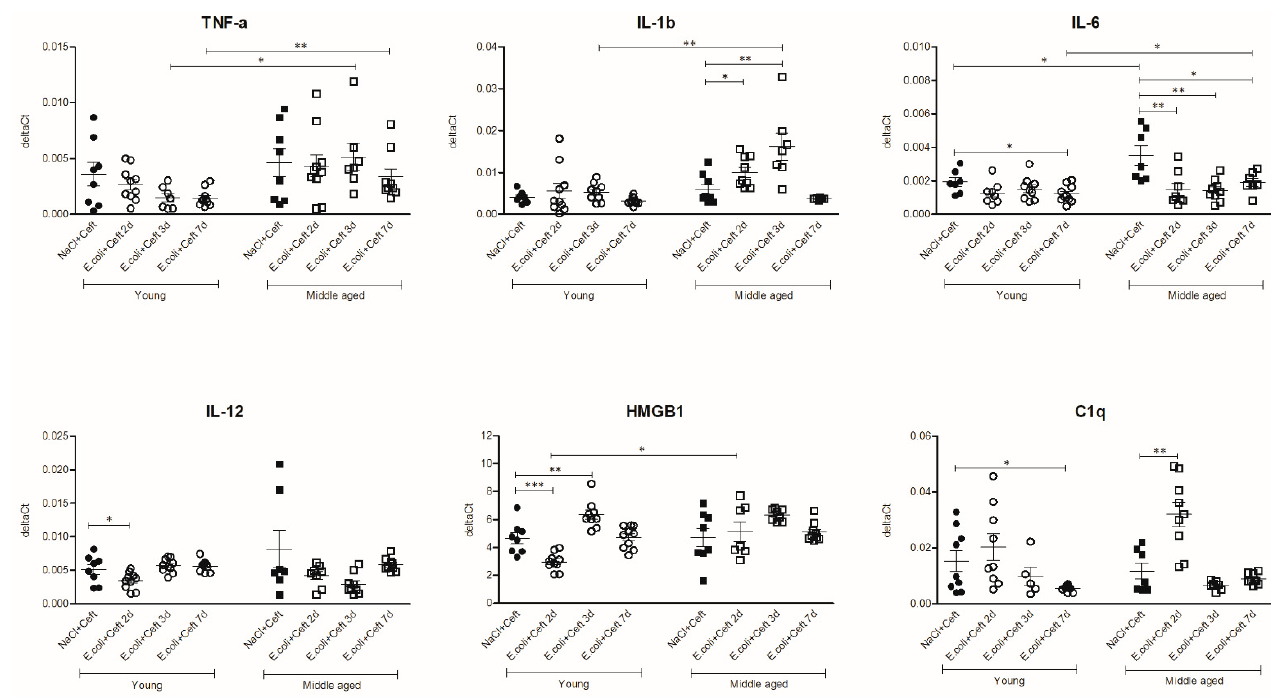
Figure 5. mRNA expression of brain homogenate of general pro-inflammatory mediators TNF- α , IL-1 β , IL-6, IL-12, HMGB1 and C1q, illustrated in deltaCts. Group size varies from n = 8 to 10. Parametric or non-parametric two-way ANOVA (factors: age and time point) werer conducted and continuous variables were tested with post-hoc Mann–Whitney U tests or Student t -tests, depending on the distribution of the data. For non-parametric ANOVAs, the ranked transformation of data was performed. Data represent mean ± SEM, * p ≤ 0.05, ** p ≤ 0.01, *** p ≤ 0.001.